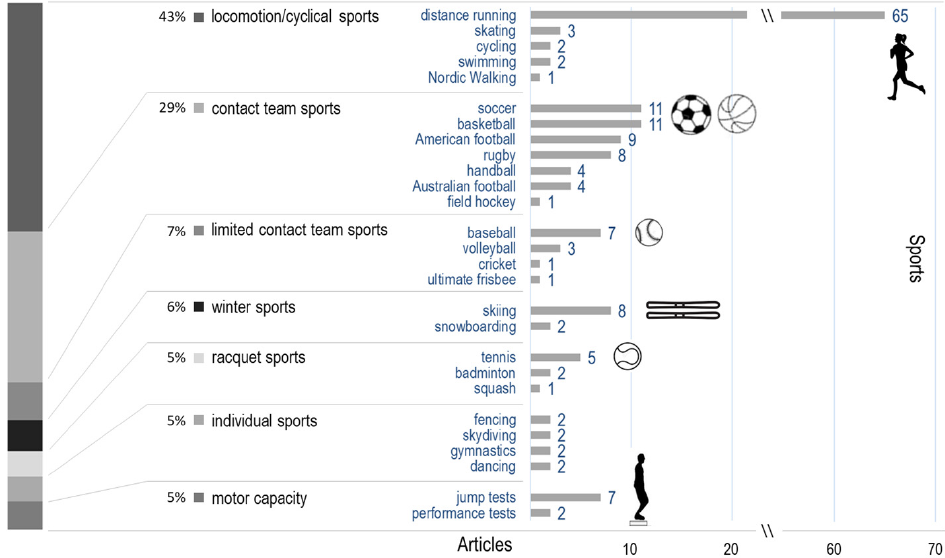
Figure 7. Breakdown of published articles by sport and motor task. Multiple counts are allowed for articles performing comparative studies across sports. Table 1. Breakdown of motor tasks investigated, classified by different gross motor skills or aims of the motor task.